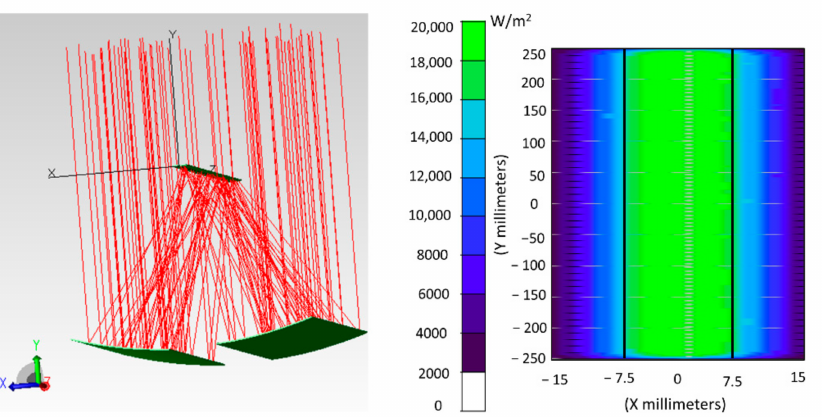
Figure 8. Optical model of the non-ideal parabolic concentrator with trace race (left side) and Irradiance map for the non-ideal parabolic trough with absorbed flux (right side).